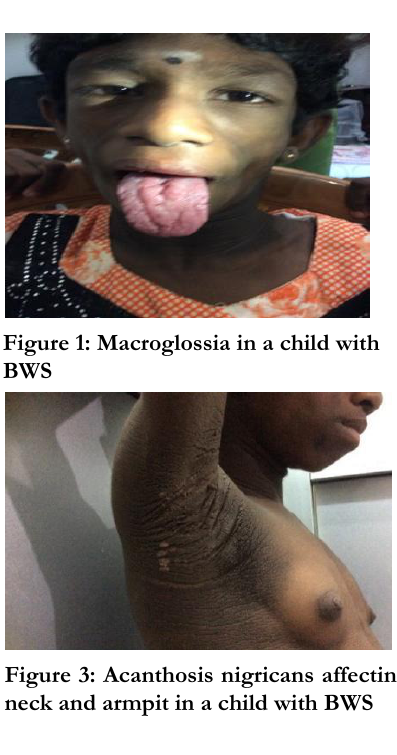
views was granted in accordance with recognized guidelines